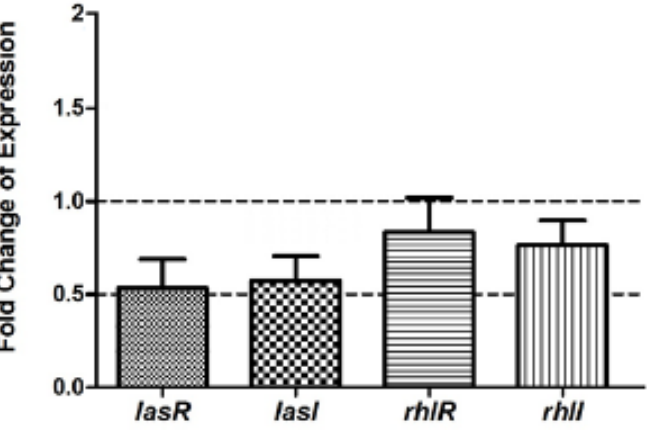
Figure 6. Comparison of lasR , lasI , rhlR , rhlI expression levels with F5 treatment relative to expression of the internal control gene rpsL in real time